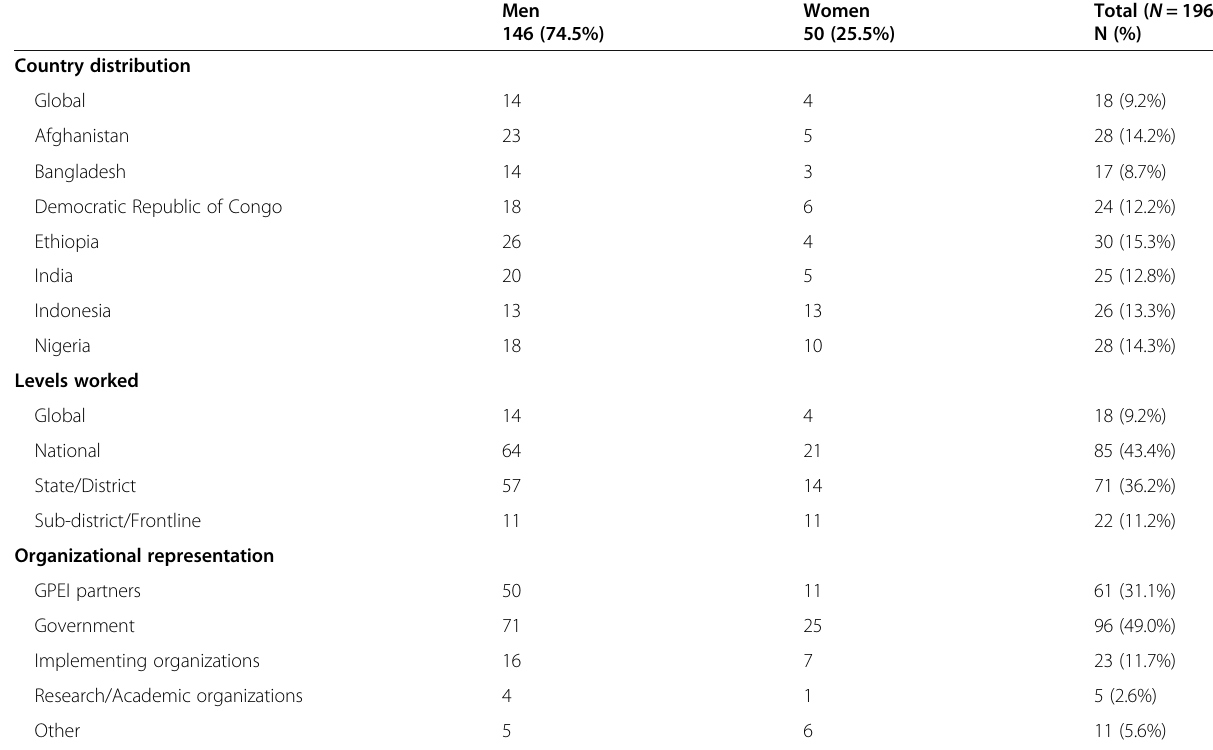
Table 1 Characteristics of KII Participants